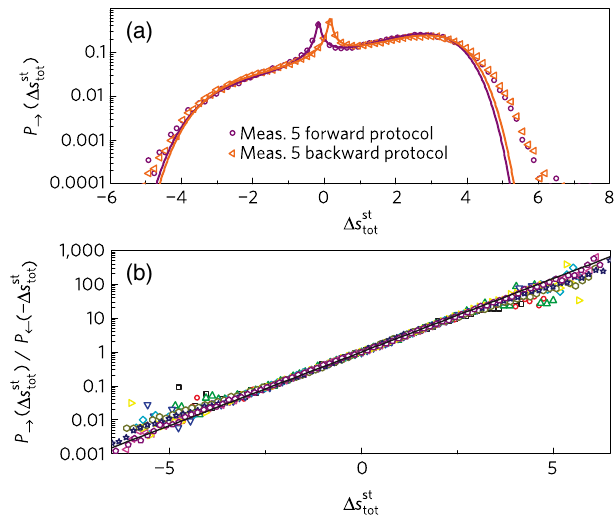
FIG. 12. (a) Probability distribution of the total entropy Δ S , tot which has been measured in the circuit shown in Fig. 11 and Þ ¼ described in the text. (b) The symmetry functions Sym ð Δ S tot Þ =P ð − Δ S Þ(cid:2) of P ð Δ S Þ as a function of Δ S log ½ P ð Δ S . In tot tot tot tot Þ , we see that spite of the highly non-Gaussian nature of P ð Δ S tot Þ ¼ k Δ S Sym ð Δ S (adapted from B tot tot